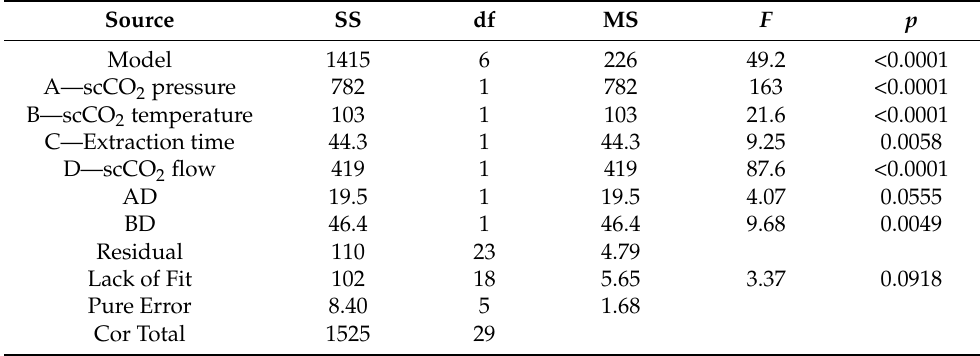
Table 2. Analysis of variance (ANOVA) for central composite rotatable design 2 4 .